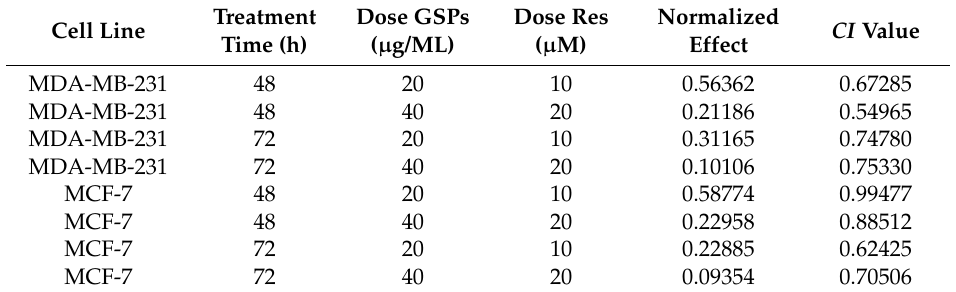
Table 1. Synergism between GSPs and resveratrol (Res) indicated by combination index ( CI )